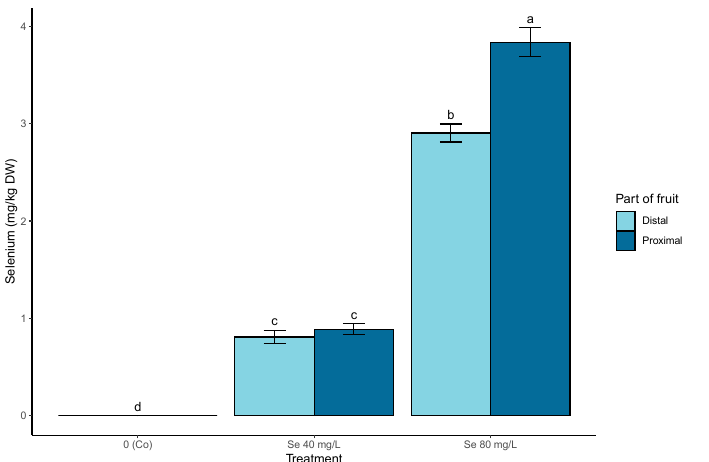
Figure 4. Content of Se in tomato fruit treated under a vacuum at 0, 5, 10, and 20 mg Se L − 1 in the form of sodium selenate. Values are the means ± SE ( n = 3). Values with the same letter are not statistically different ( p ≤ 0.05).